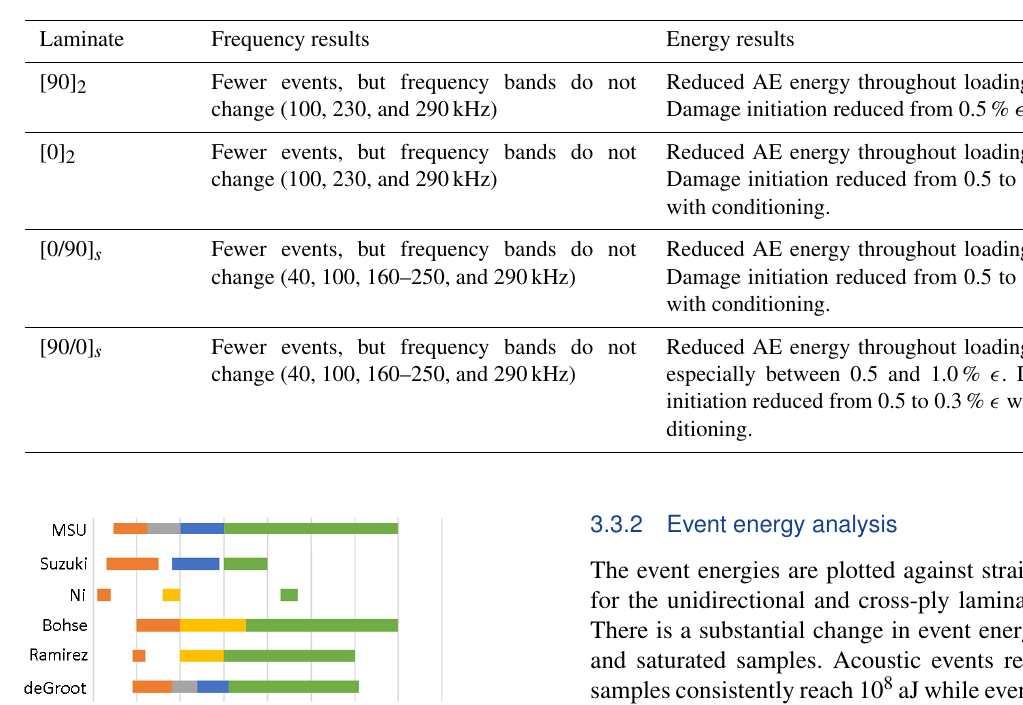
Table 2. Summary of changes in AE response from dry conditions to saturated conditions.